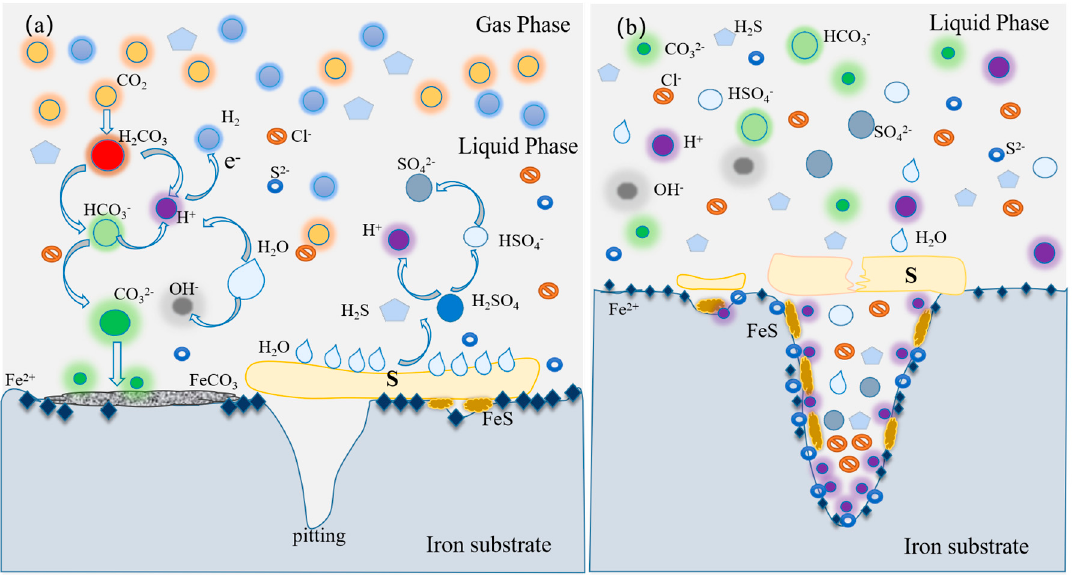
Figure 12. Description of corrosion mechanism of L360 pipeline steel under S8 deposition in NaCl solution containing CO 2 : ( a ) S8 non-uniform deposition, ( b ) under S8